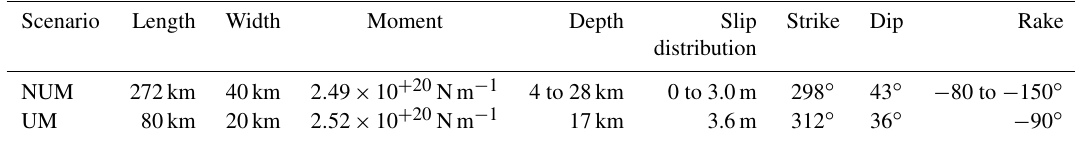
Table 2. Rupture orientation parameters investigated in sensitivity tests. Strike ( (cid:56) , degrees) Dip ( δ , degrees) Rake ( λ , degrees) 290 . 0 , 298 . 0 , 305 . 0 , 312 . 0 , 320 . 0 25 . 0 , 36 . 0 , 43 . 0 , 55 . 0 , 60 .